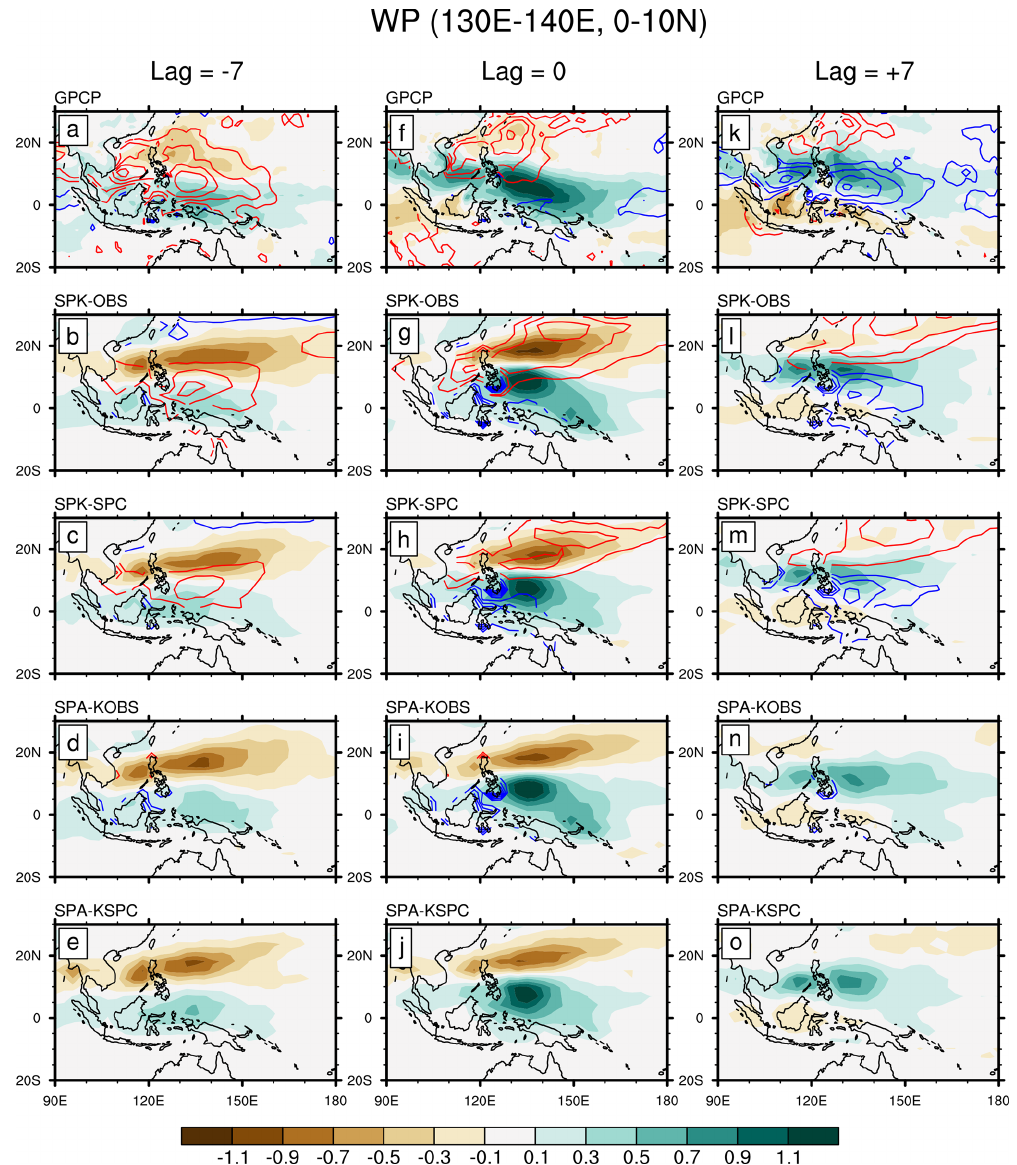
Figure 7. Same as Fig. 6, except for variables regressed onto (0–10 ◦ N, 130–140 ◦ E) averaged intraseasonal precipitation over the western